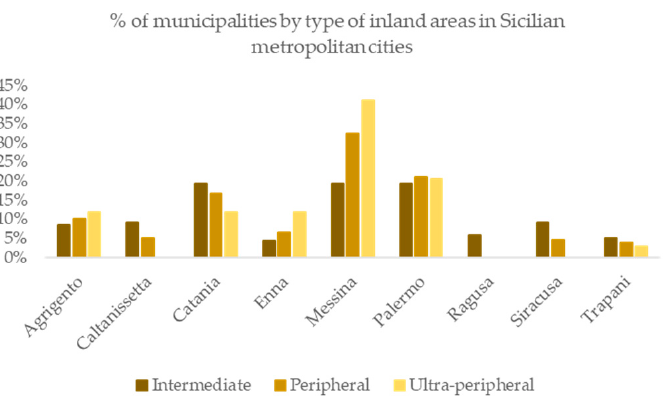
Figure 5. Percentages of municipalities by type of inland areas in Sicilian metropolitan cities. (Authors’ elaboration from NSIA data.)